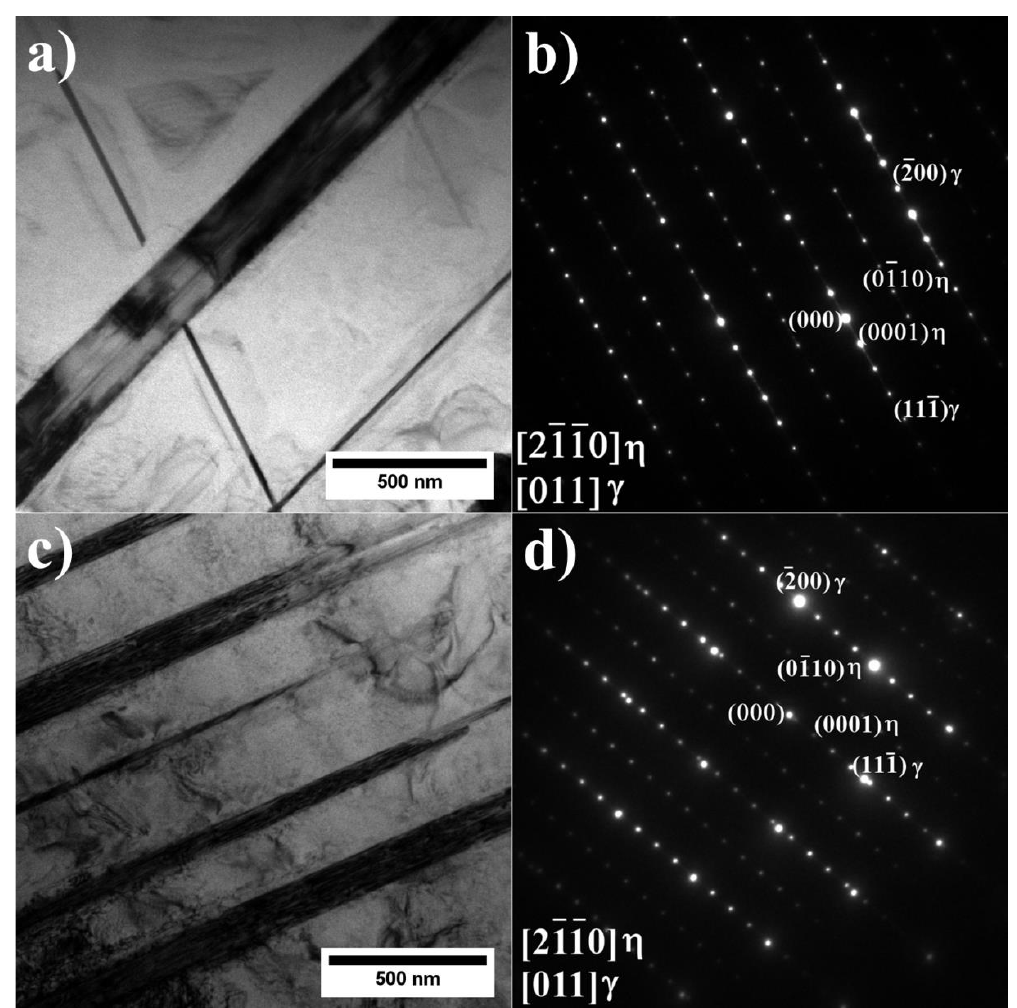
Figure 11. η phase precipitates with corresponding SAED patterns: ( a , b ) A3; ( c , d ) A6, TEM-BF. It has been stated that those precipitates are the η (Ni 3 Ti) phase with an ordered DO 24 hexagonal closed packed structure and nominal lattice parameter a = 5.096 Å and c = 8.3040 Å [32]. The SAED patterns confirmed that the η phase precipitates are incoherent with the γ matrix. The results suggest that large amounts of Ti and Ta favor the appearance of the η phase. It is especially visible in superalloys with a low Al/Ti ratio, as the addition of Ta causes the amount of η phase to increase compared to remelted IN740 [24]. The lack of η precipitates in superalloys A4 and A5 indicates that the increased Al concentration upon the addition of Ta at 2.0–3.0 wt% could prevent η phase formation. The results are in line with the conclusions formed by Bouse [33], who stated that the appearance of the η phase is favored by large amounts of Ti and Ta in Ni-based alloys. Seo et al. [34], based on microstructure observations of directionally solidified IN792 + Hf, indicated that the η phase was the final solidification product formed from the residual liquid after the γ - γ’ eutectic reaction. The authors stated that the concentration relationship (Ti + Ta + Hf)/Al in the residual liquid has a significant role in the nucleation of the η phase. During the solidifi cation of eutectic γ - γ’ phase, the continual increase in the (Ti + Ta + Hf)/Al ratio in the residual liquid eventually led to the completion of the γ/γ’ eutectic reaction. Con- sequently, it caused η phase nucleation. According to theoretical calculations, the η phase has significant solubility for other alloying elements such as Co, Al, Cr, and W [35]. Kruk et al. [36] revealed by STEM-EDX analysis of the precipitates in the 718Plus alloy that Nb can also be present in η phase plates. Tan et al. [37] suggested that when the Ti/Al ratio in the liquid phase is higher than around 2.0, the η phase is favorable to form ; however,